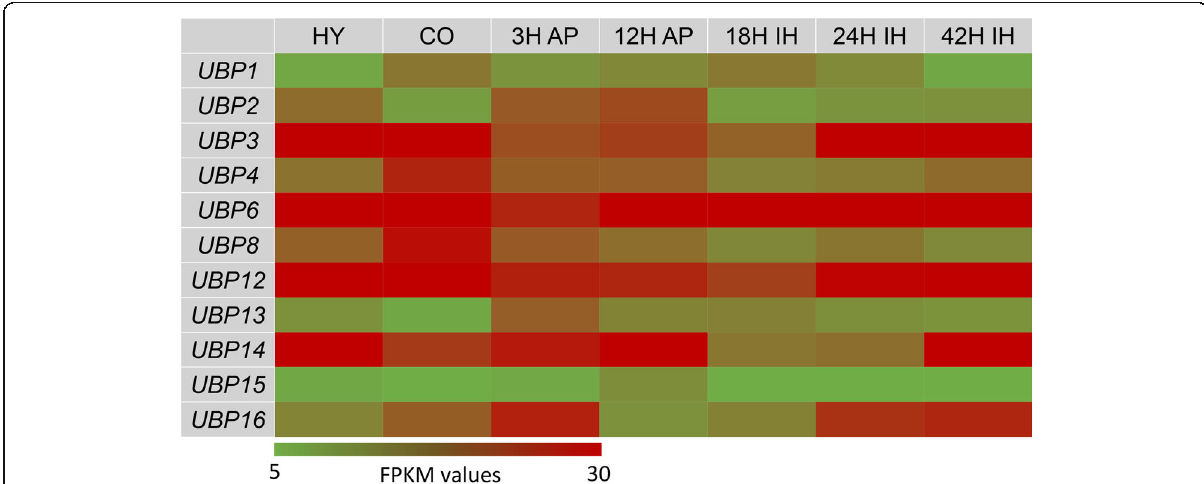
Fig. 2 The heat map shows expression patterns of UBP genes at different developmental stages. The expression level of each gene relative to the mean FPKM (Fragments Per Kilobase of transcript per Million mapped reads) value across all the experimental stages on the log scale has been represented. The color (from green to red) indicates gene expression intensity from low to high. HY: Mycelial hyphae; CO: Conidia; 3H AP: appressoria at 3 hpi; 12H AP: appressoria at 12 hpi; 18 IH: invasive hyphae at 18 hpi; 24 IH: invasive hyphae at 24 hpi; 42 IH: invasive hyphae at 42